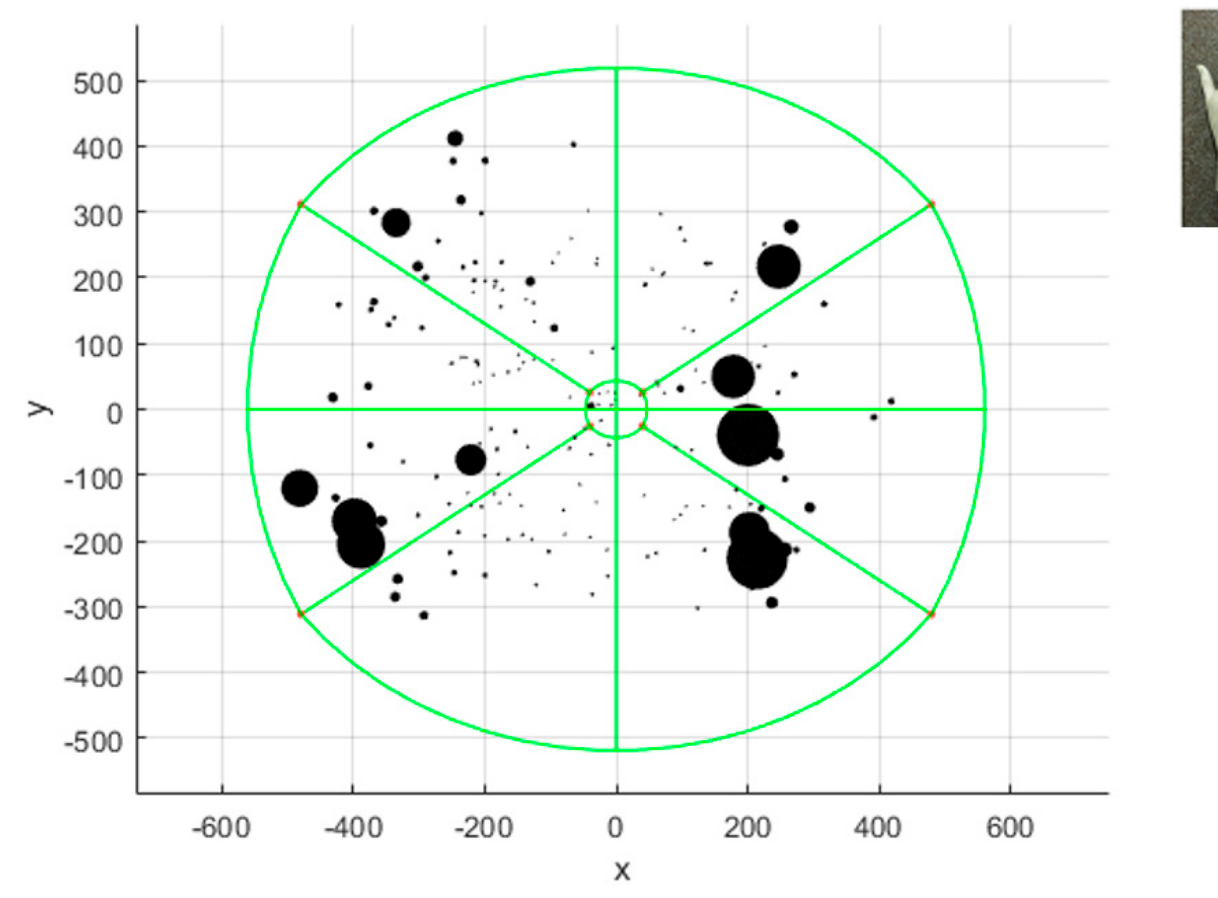
Figure 6. Up to 60 cm: top–bottom view. x and y axis are in